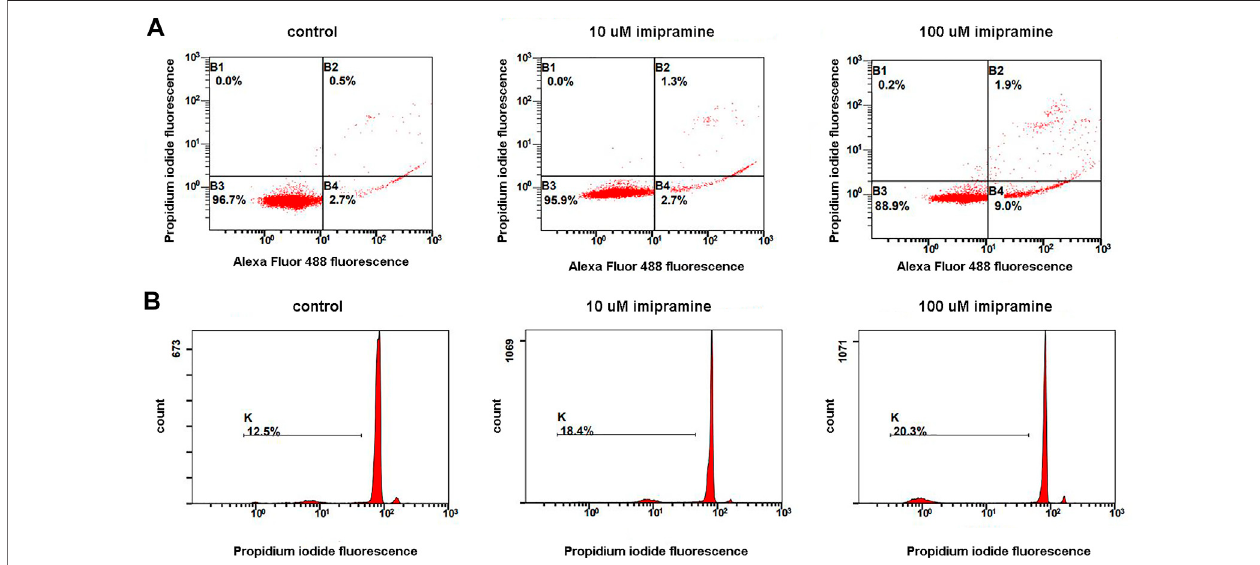
FIGURE4| Adose-dependentapoptogeniceffectofimipramineonneutrophilswerecultured inRPMI-mediumat37 ° C,5%CO 2 undercontrolconditionsorinthe presence of 10 or 100 µM imipramine. Early apoptosis (4 h incubation) was assessed by the severity of membrane changes using double AnnexinV/PI-labeling. Late apoptosis (18 h) was judged by DNA fragmentation quantifying using PI-labeling of permeabilized cells (B) . (A) Representative dot plots indicative of apoptosis by phosphatidylserine externalization,aswellastheproportionsofviable(regionB3),earlyapoptotic (regionB4),and lateapoptoticand necroticcells(regions B2and B1), are indicated for the control and imipramine-treated neutrophils. (B) Representative histograms of nuclear DNA fragmentation. K shows the degree of hypodiploid (apoptotic)